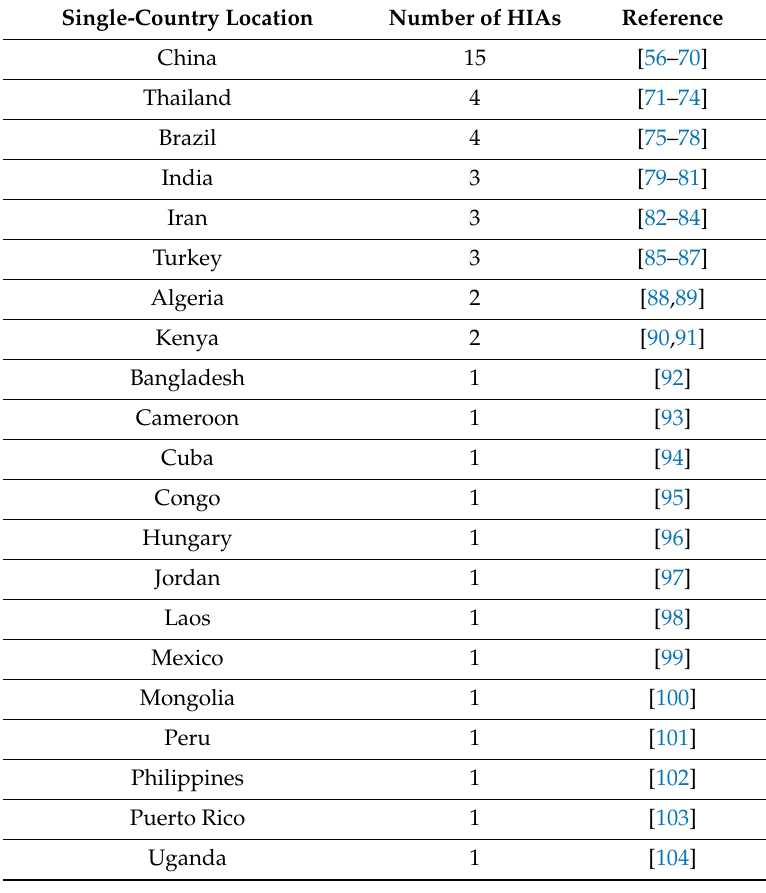
Table 2. Number of studies by